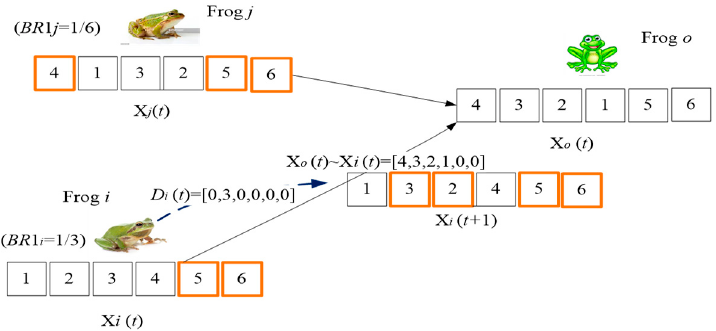
Figure 6. Frogs i and j jump towards the target frog o.